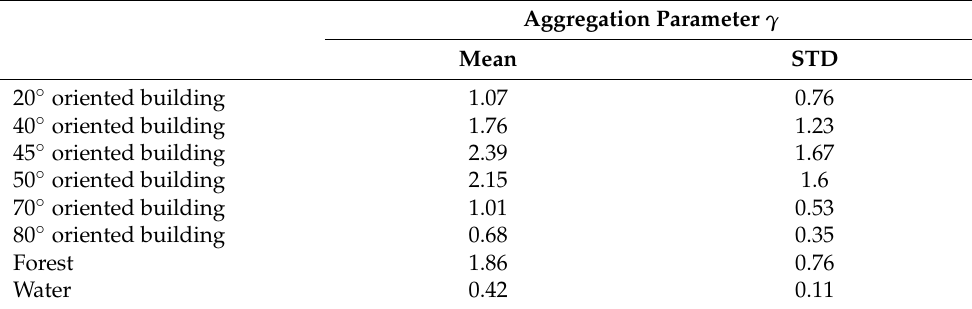
Table 2. The statistical results of the aggregation parameter γ for 8 types of samples over San Francisco, USA.